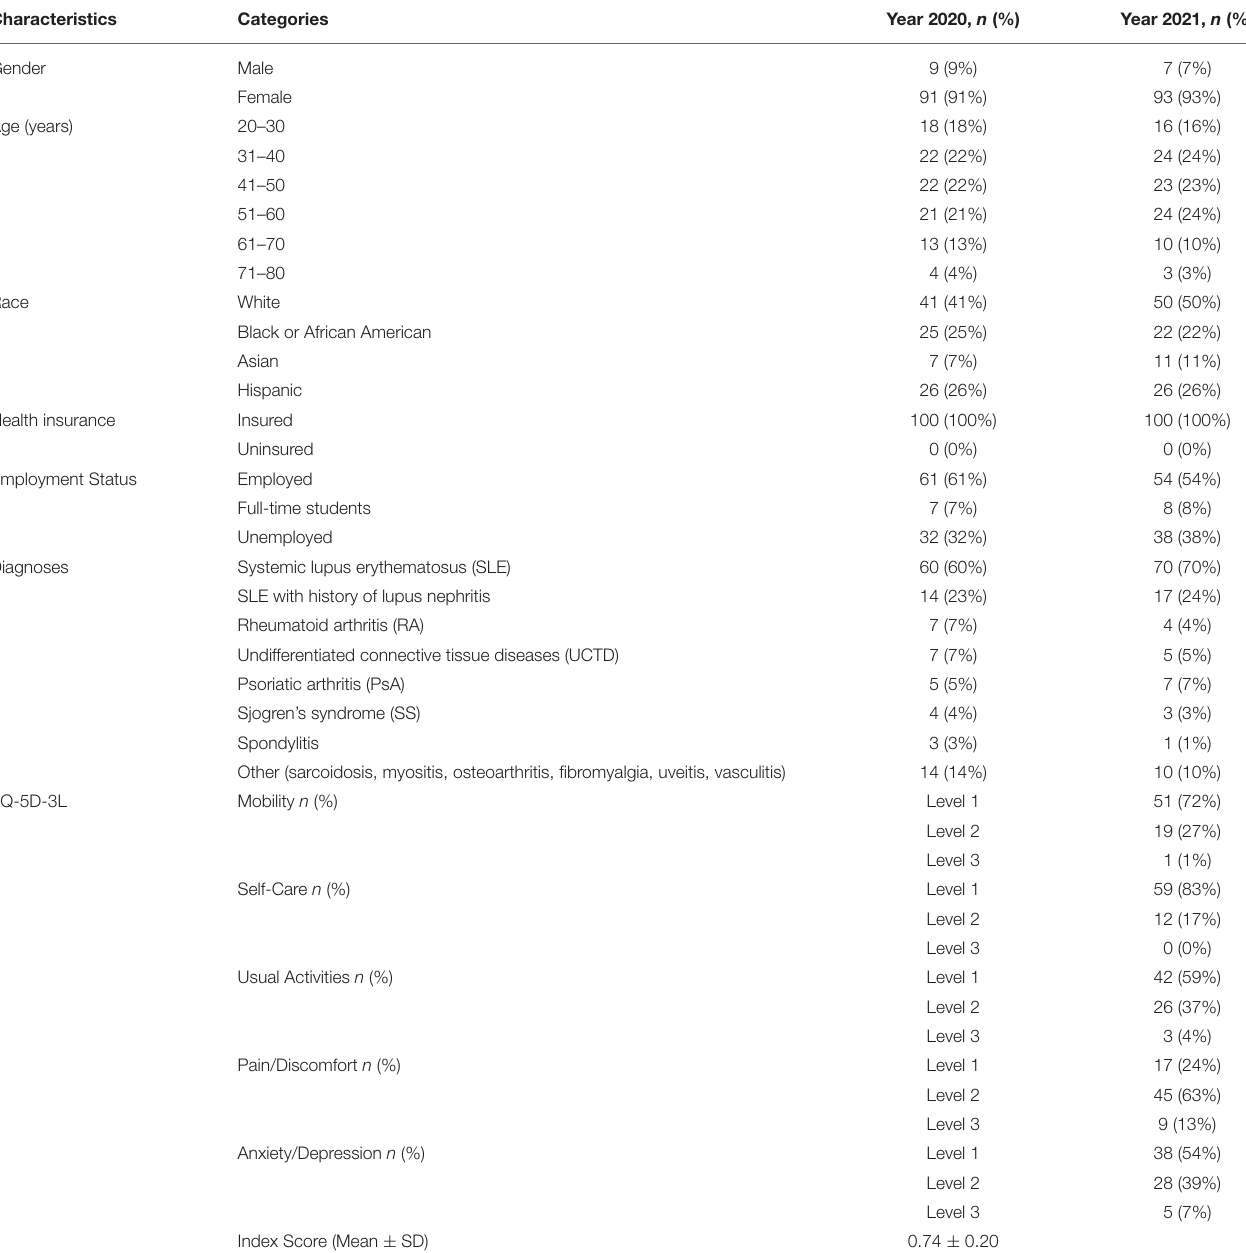
TABLE 1 | Patient characteristics of the survey